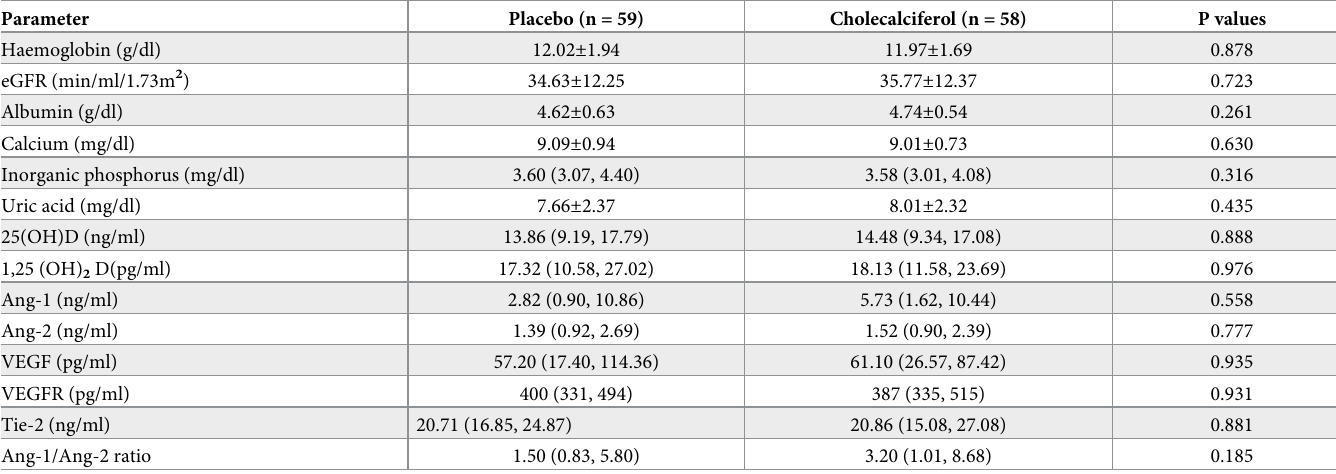
Table 2. Baseline level biochemical and circulating biomarkers in study